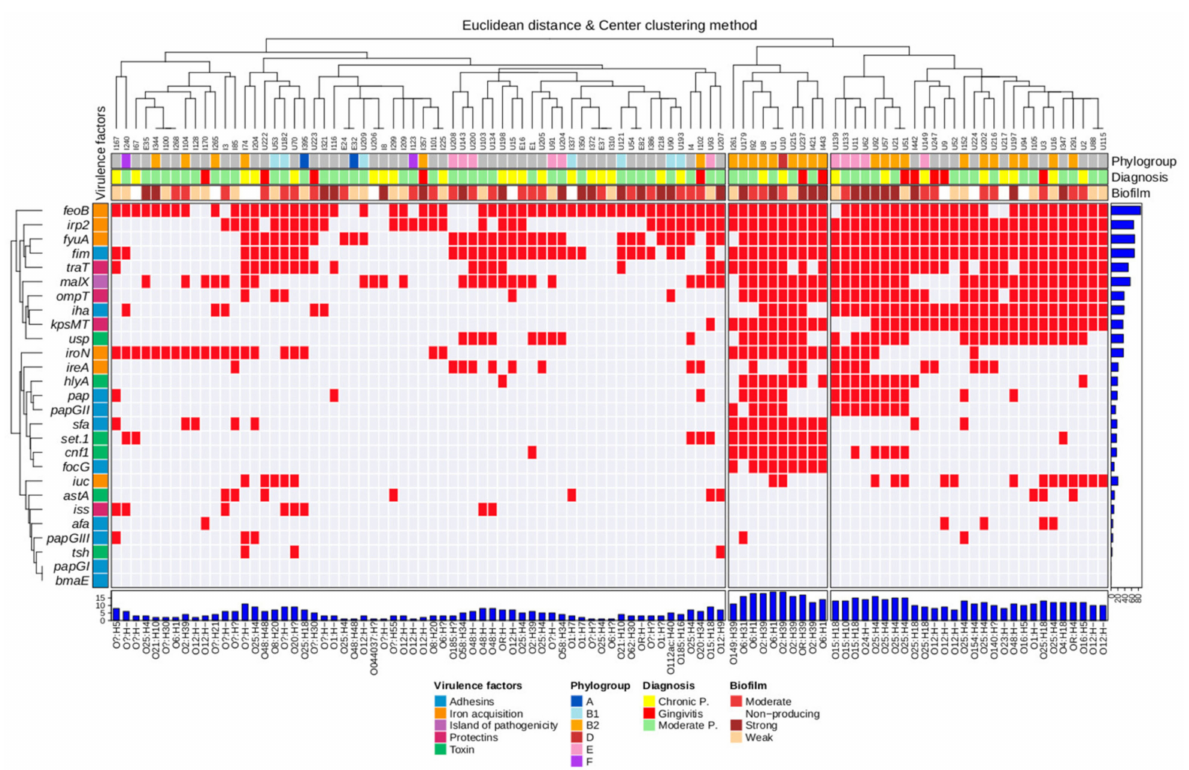
Figure 1. Hierarchical clustering of E. coli strains according to the virulence genotype profile and its relationship with biofilm production, phylogroups, serotypes, and diagnoses. Positivity and negativity for a given genotype are represented by a red and gray “rectangle” respectively. Genetic functions, biofilm production, phylogroups, serotypes, and diagnostics are color-coded as indicated in the key below. Cladograms of the strains and genes are shown along the top and “left” respectively. Upper axis: ID of the strains. Left axis: name of the virulence genes. Right blue bars: detection percentage of each virulence gene. Lower blue bars: number of virulence genes detected in each strain. Lower axis: serotypes identified in each